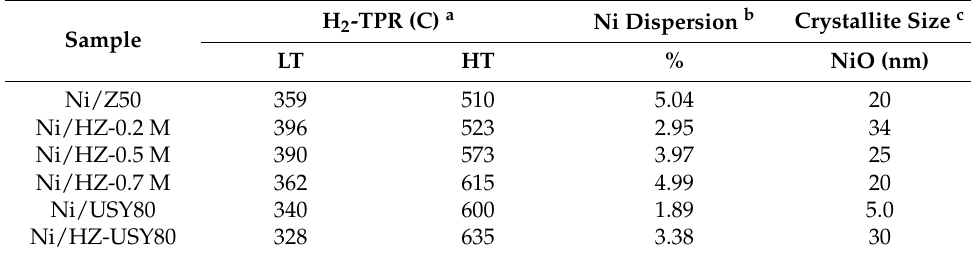
Figure 5. TEM images of ( a ) HZ-0.5 M and ( b ) Ni-HZ-0.5 M samples. Table 2. Chemisorption data of Ni-supported